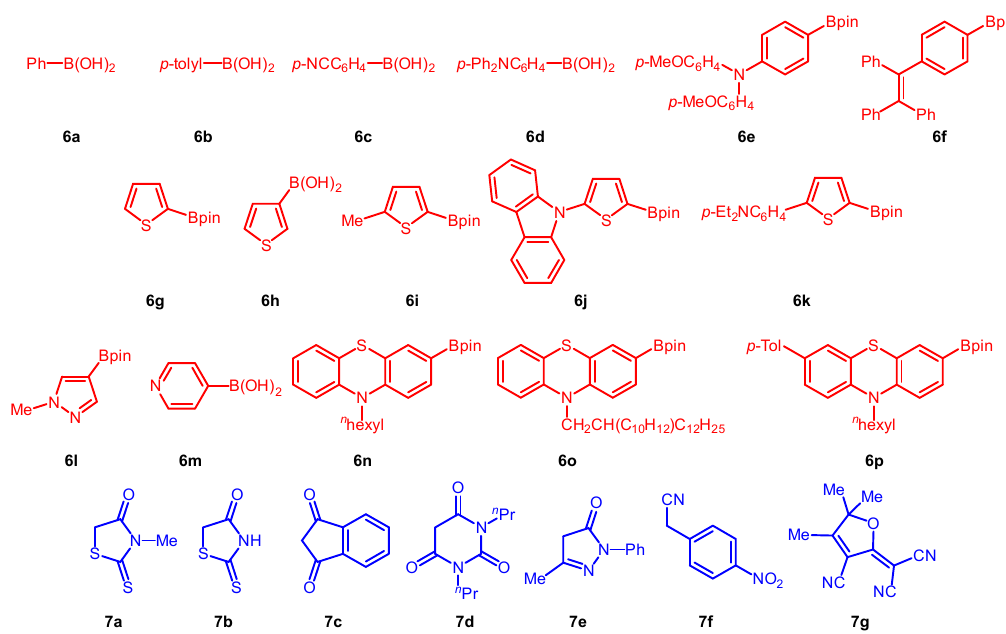
Scheme 3. (Hetero)aryl boronates or boronic acids 6 (red) and methylene active compounds 7 (blue) employed in consecutive three-component Suzuki–Knoevenagel syntheses.